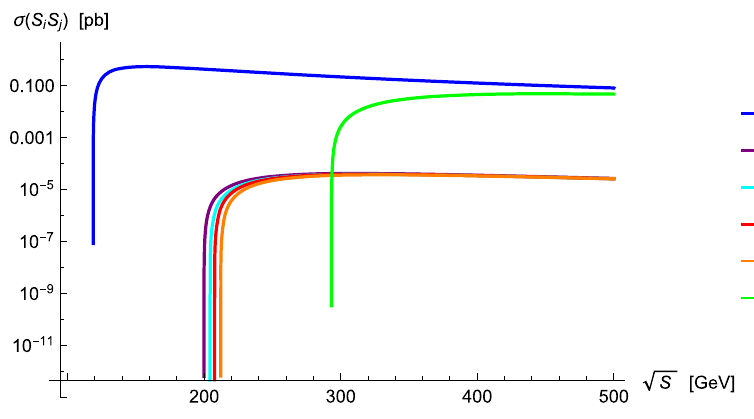
Fig. 3 The e + e − → Z ∗ → S i S j cross section for BP B with masses in